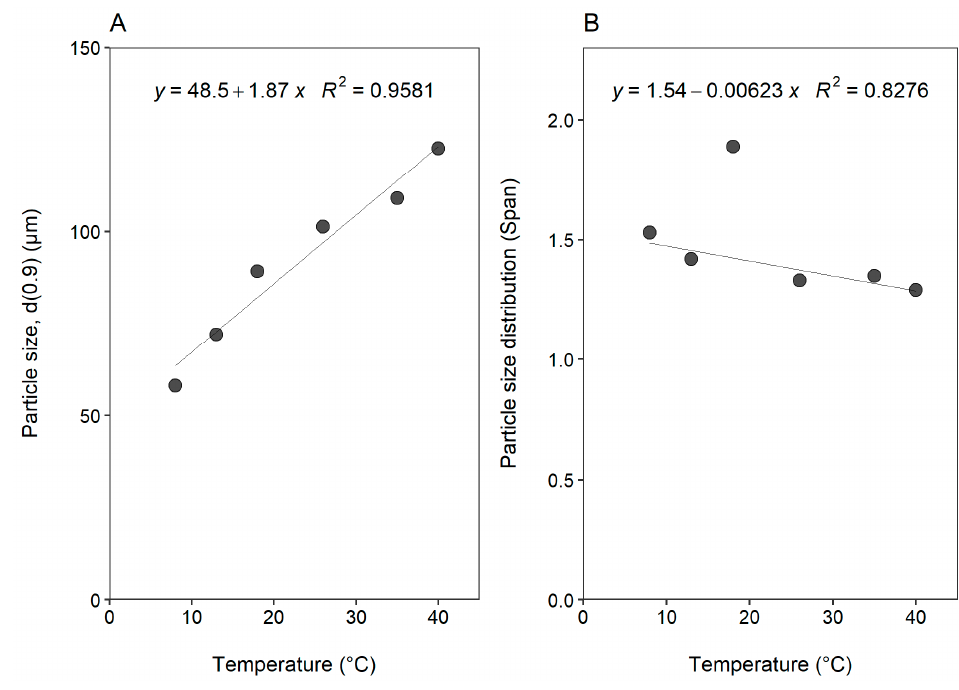
Figure 3. The effect of temperature on ( A ) particle size (d(0.9)) and ( B ) particle size distribution